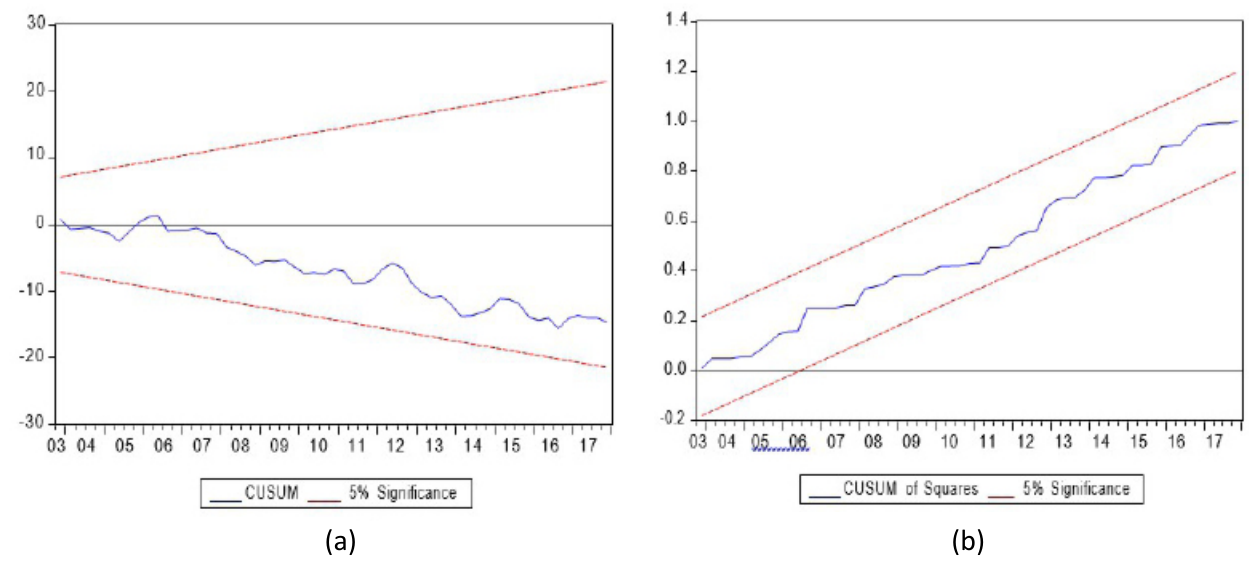
Figure 3: Growth M2 Indonesia Stability with CUSUM test (a) and CUSUMQ test